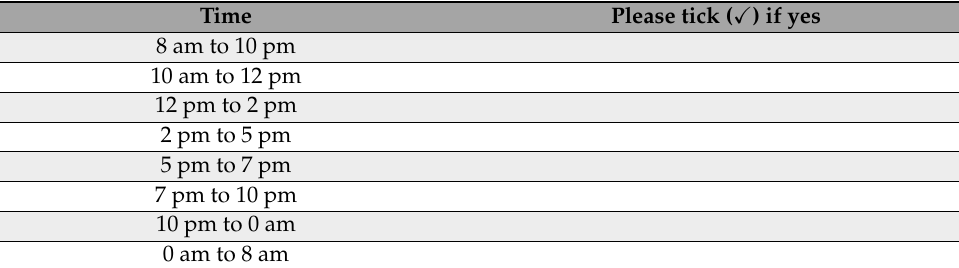
Questions about the spatial experiences and perception of social informal learning spaces in higher education.